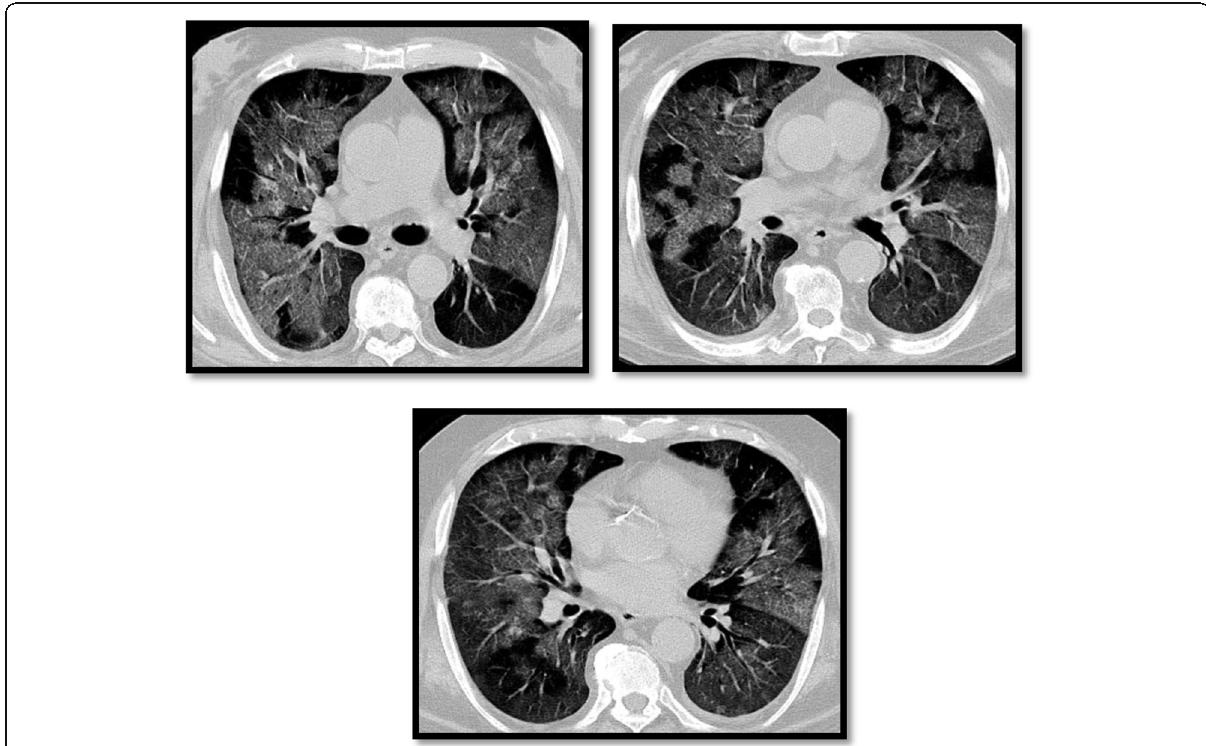
Fig. 7 A male patient, 48 years old, presented by severe respiratory distress. MSCT was done showing bilateral diffuse patchy ground-glass opacification with superimposed prominent intralobular septae giving crazy paving